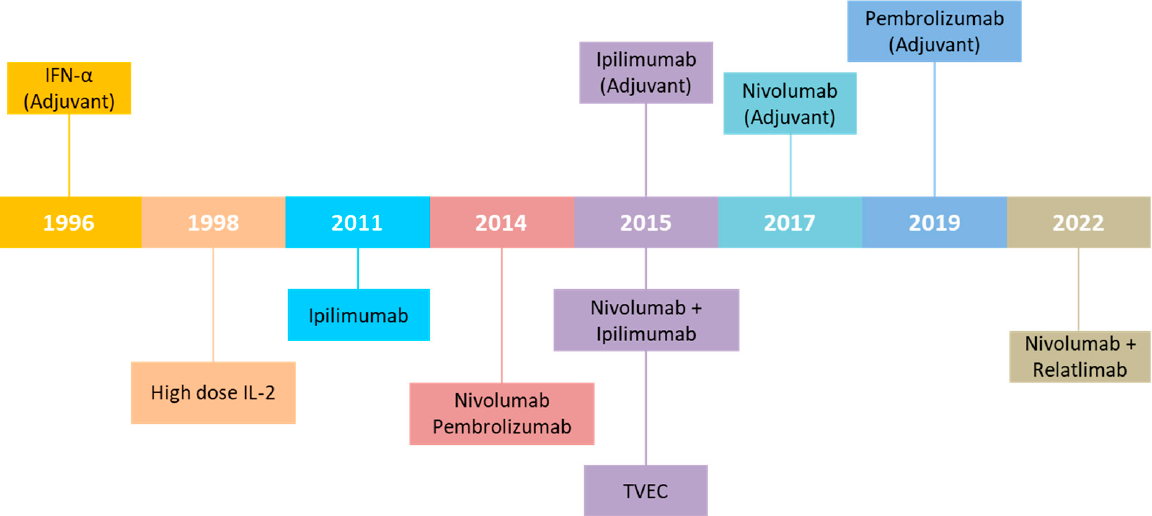
Figure 3. Timeline indicating immunotherapies approved by the FDA for the treatment of patients affected by melanoma (https://www.accessdata.fda.gov/scripts/cder/daf/index.cfm, (accessed on 20 December 2022).